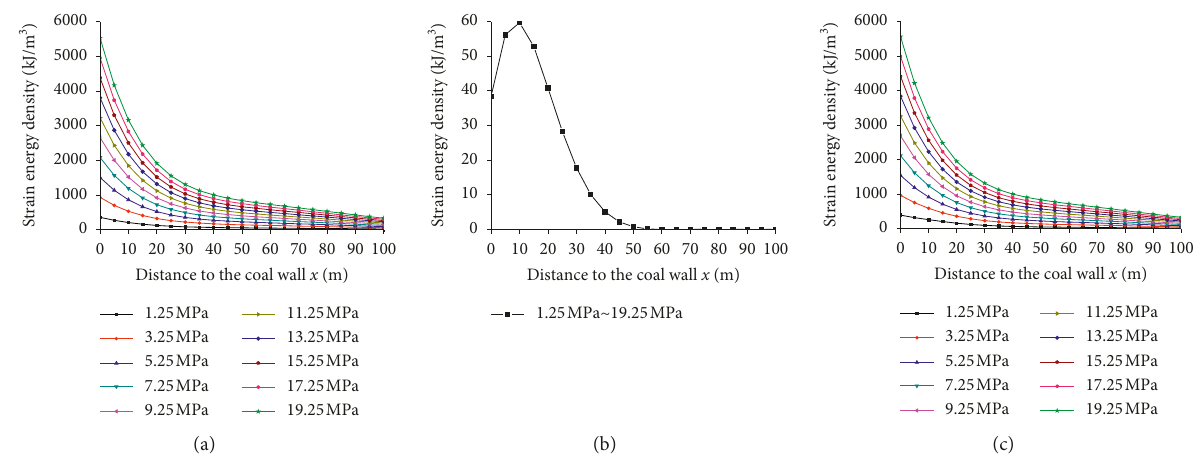
Figure 12: Strain energy densities before the initial roof breakage event. (a) Coal mass. (b) Roof rock mass. (c) Overall working